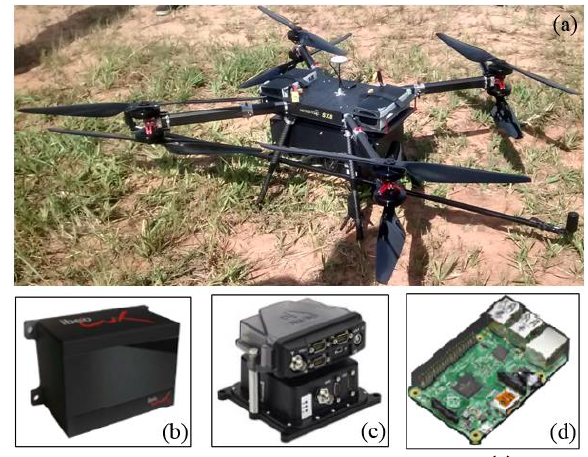
Figure 1. Lightweight low-cost UAV-ALS system: (a) UAV- ALS system; (b) Ibeo LUX unit; (c) navigation system and (d) recording unit (Raspberry